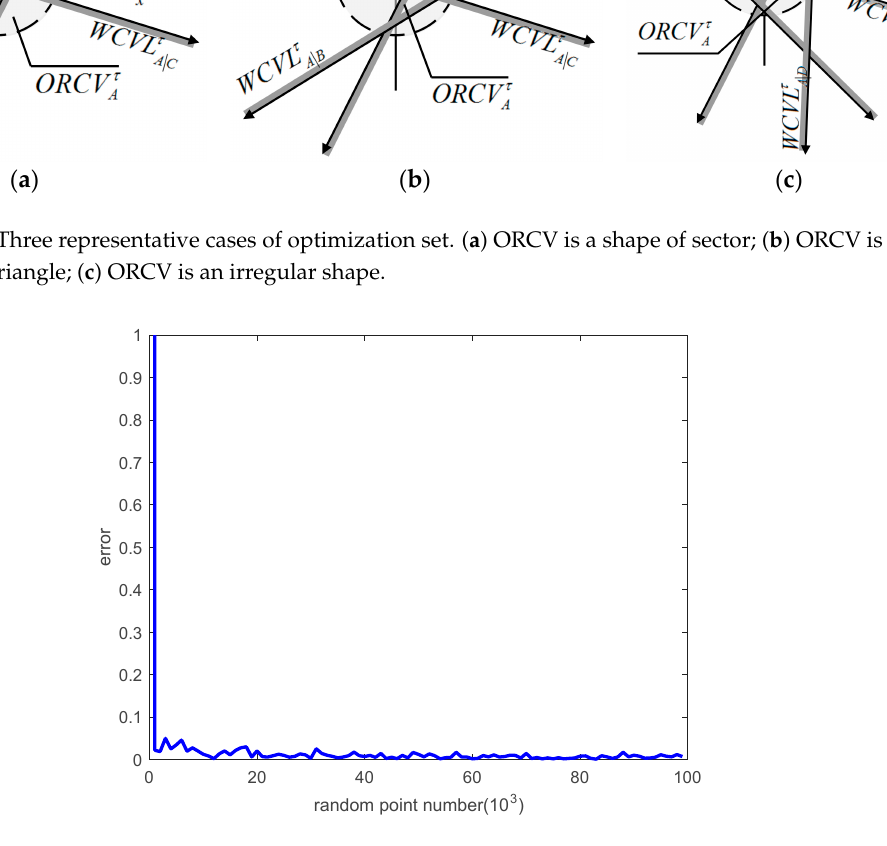
Figure 10. Two situations of null set. ( a )